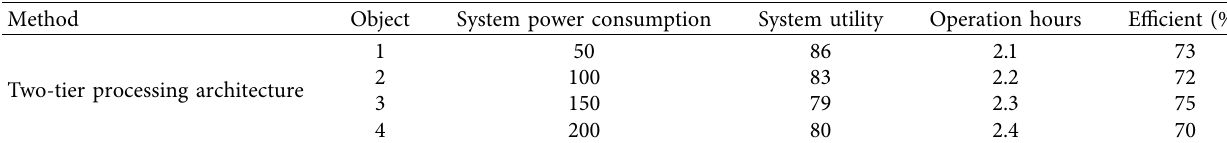
Table 4: System utility table for three-tier processing architecture with the same system power consumption.